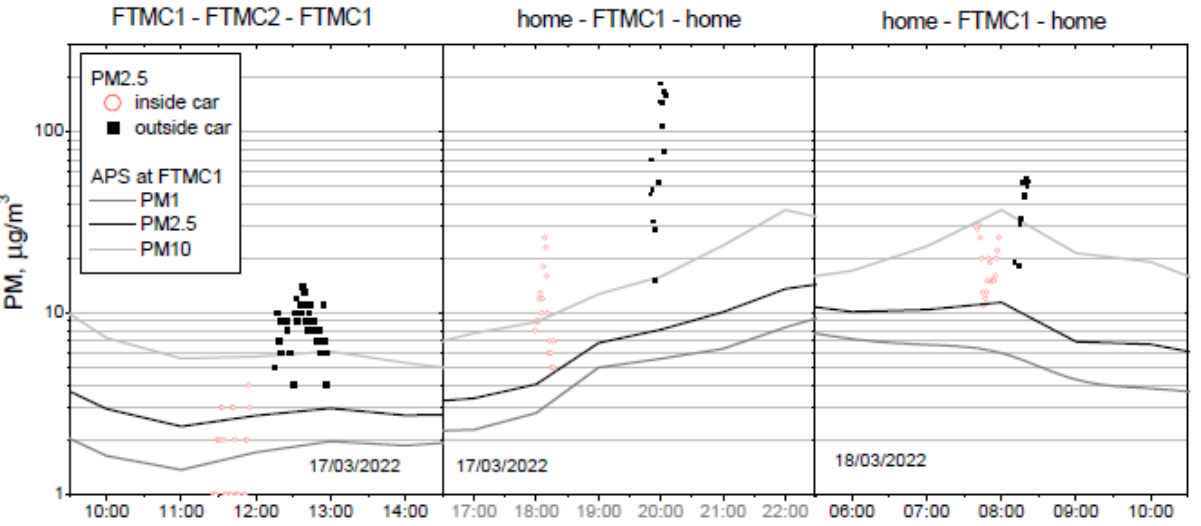
Figure 4. Timing of field experiments and PM 2.5 mass concentrations measured during each route inside (red circle) and outside (black rectangle) the vehicle, and mass concentration of PM 1 (grey line), PM 2.5 (black line), and PM 10 (light grey line) at the urban background site located at FTMC1.